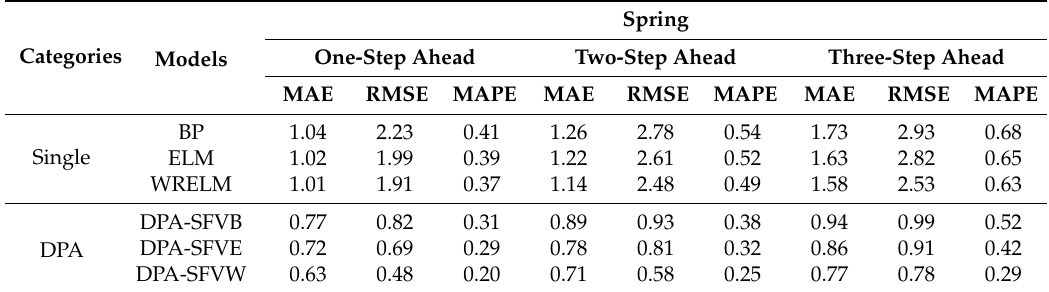
Table 6. Comparison of the prediction performances of different models in